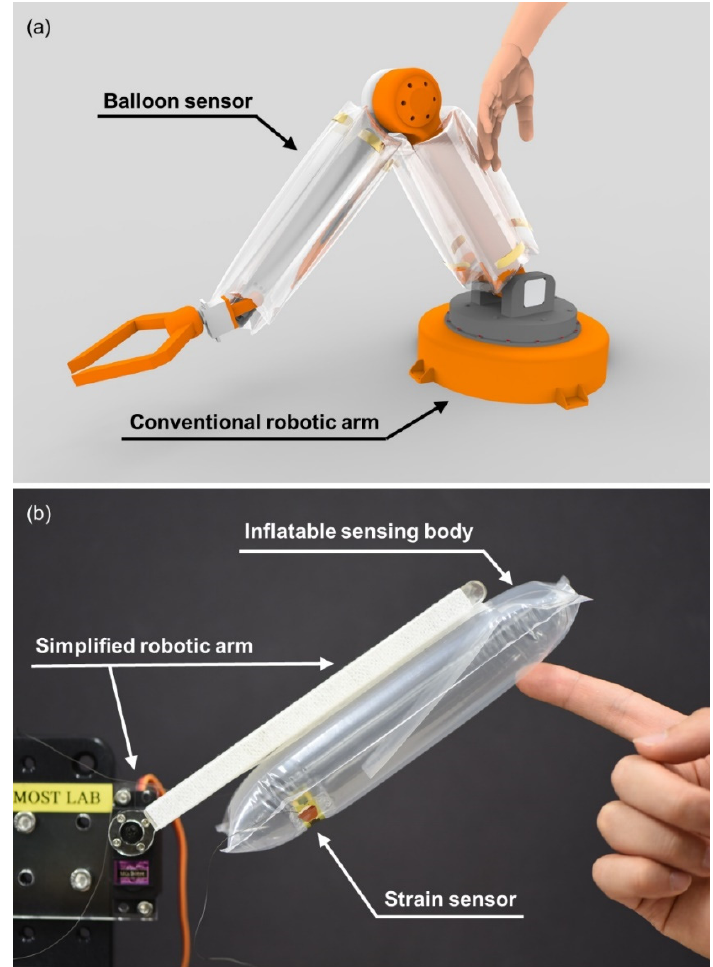
Figure 1. ( a ) Concept design of an application of balloon sensors covering a robotic arm; ( b ) the prototype of the balloon sensor integrated with a simplified robotic arm.